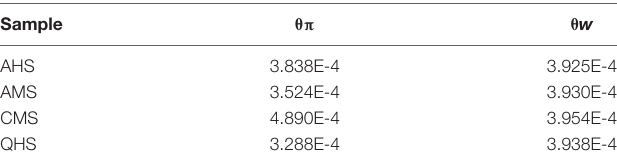
compared between CMS and AHS ( Supplementary Figure S7